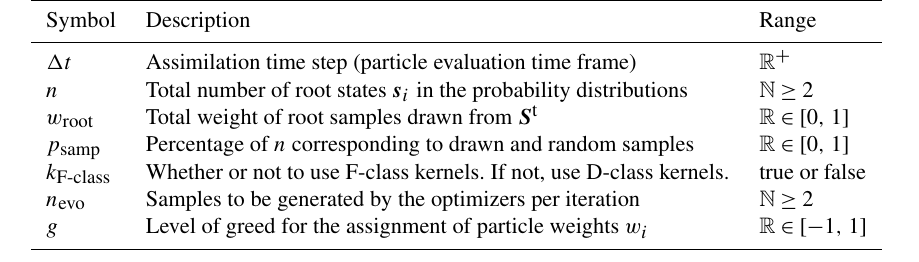
Table 2. List of global parameters in OPTIMISTS.